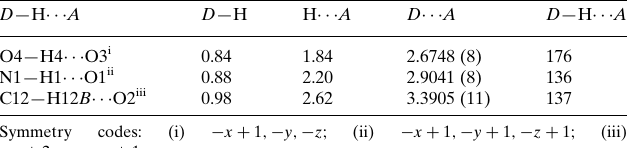
Hydrogen-bond geometry (A˚ , (cid:2)